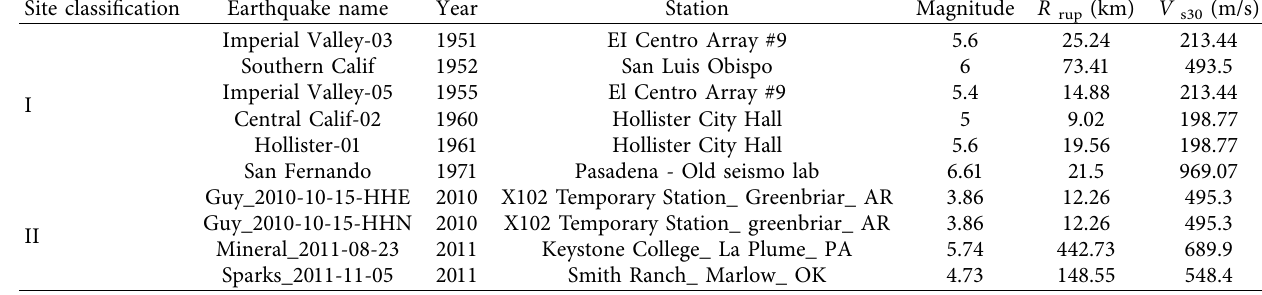
Table 4: Information of the selected seismic records.